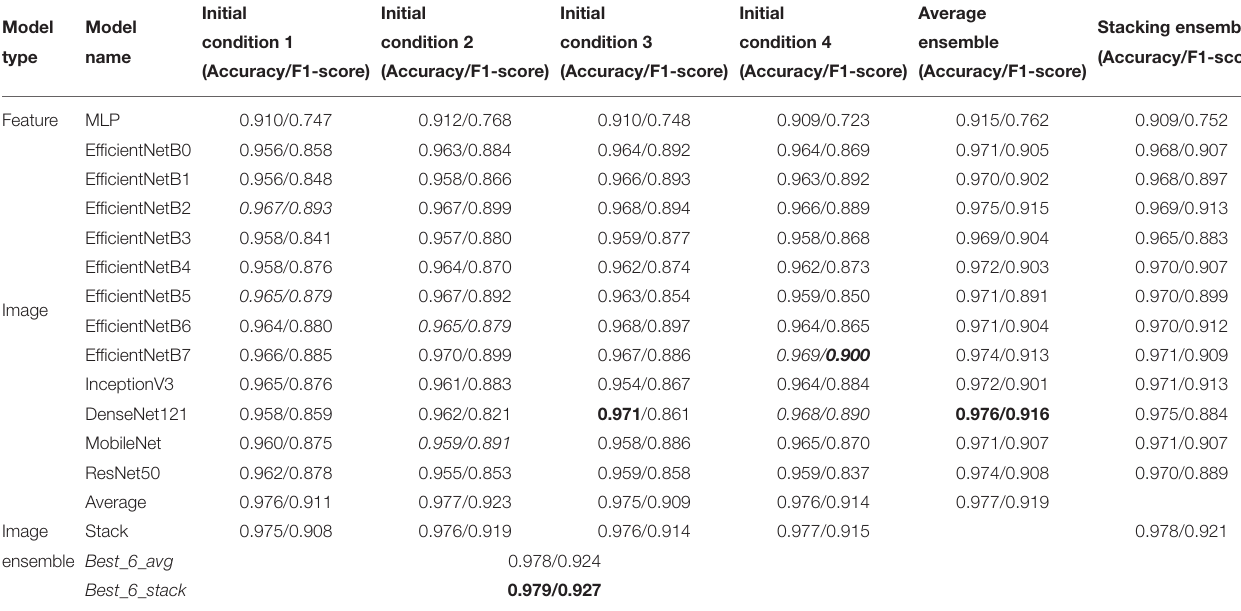
TABLE 1 | Test accuracy and F1-score of the individual models across four different initial